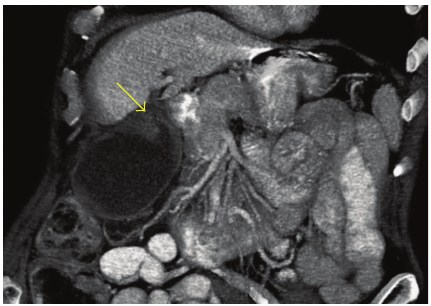
Figure 1: Obstructed, haemorrhagic gallbladder and clockwise 270 degrees rotation around the gallbladder longitudinal axis.